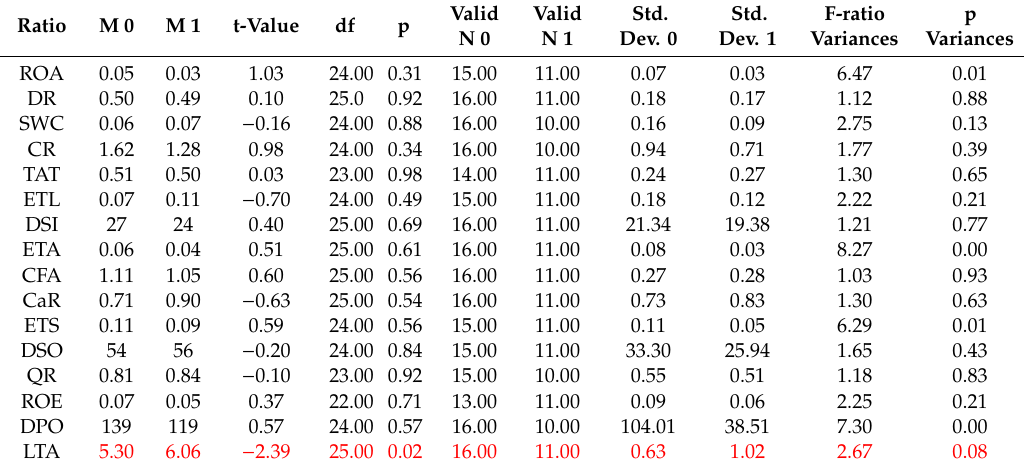
The red color means that di ff erences in the values of individual indicators are statistically significant.